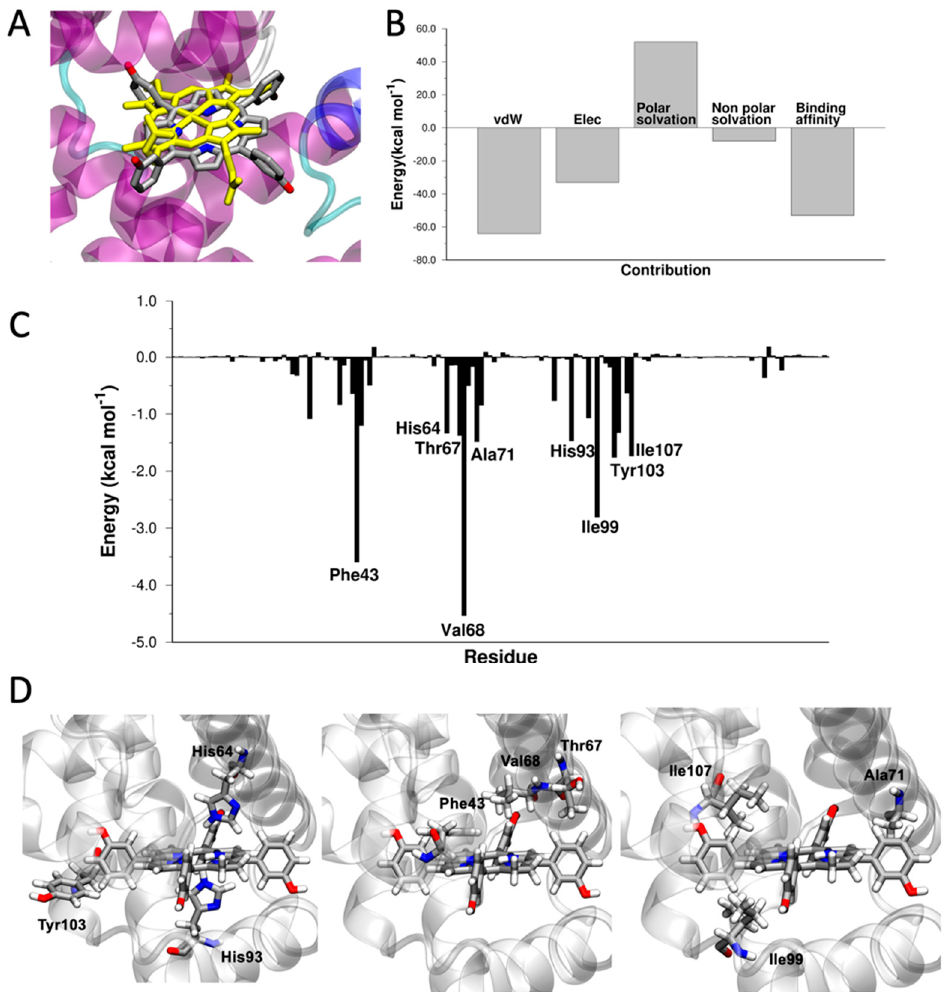
Figure 3. ( A ) Superposition of the crystallographic structure of heme (in yellow, PDB 3rgk) and docked structure of mTHPC in the heme-binding site of Mb. ( B ) Energy components of Δ E binding . ( C ) Δ E binding decomposed per residue. ( D ) Graphical representation of the interaction between Phe43, Val68, Ala71, His93, Ile99, Tyr104, Ile107, and mTHPC. Images created with VMD [73].